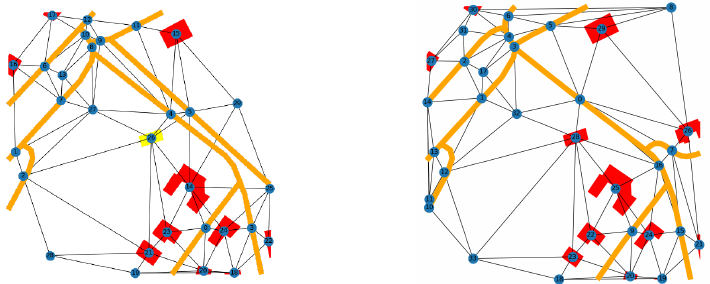
Figure 6. An example of the resulting graphs representing the same geographical area at two different time points. ( Left ): 2004. ( Right ): 2019. The detailed geometries are shown for the reference, their categories are color-coded: red = building, orange = road segment, yellow = building from a special category (such as church, monument, castle, etc).